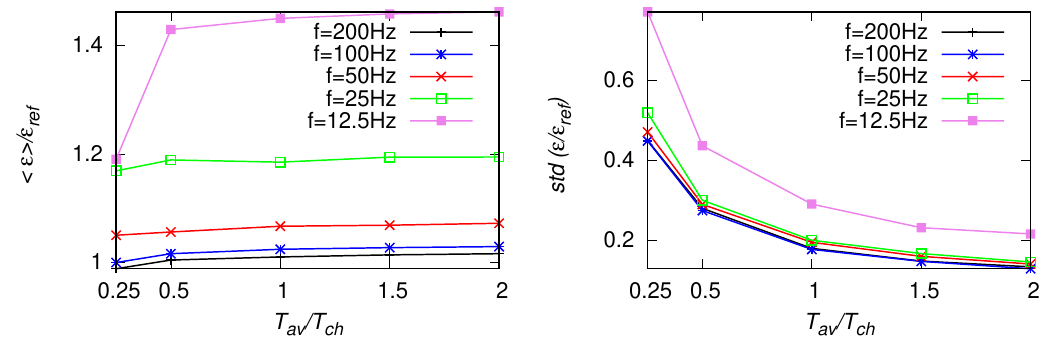
Figure 9. As in Figure 7, but for the fitting range f = [ 1 ÷ 5 ] Hz.